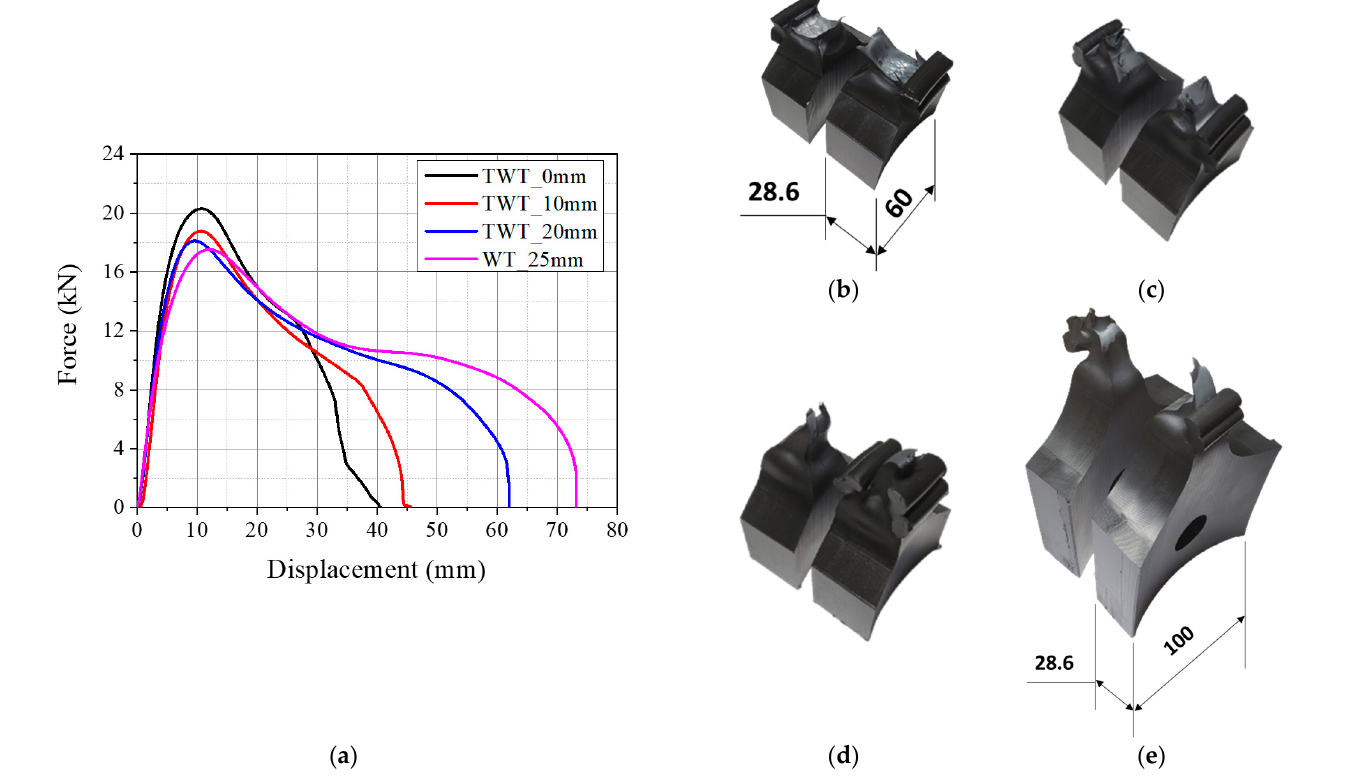
Figure 8. Results of 315 SDR 11 (Type B specimens) pipe BF joint (unit: mm): ( a ) load–displacement curves; ( b ) TWT)_0 mm; ( c ) TWT_10 mm; ( d ) TWT_20 mm; ( e ) WT_25 mm reduced parallel side length. Table 6. Maximum load and corresponding displacement of Type B, 315 SDR 11 TWT, and WT specimens.